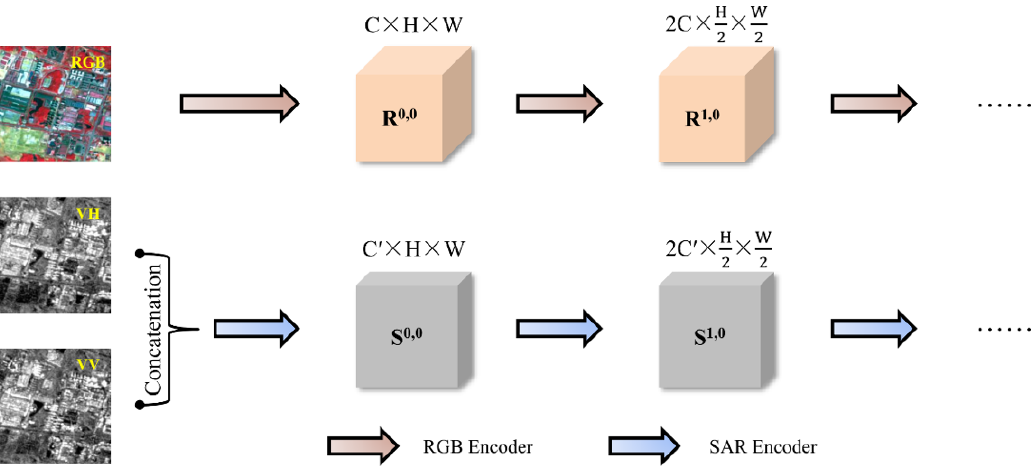
Figure 4. Feature extraction branch from optical and SAR images.